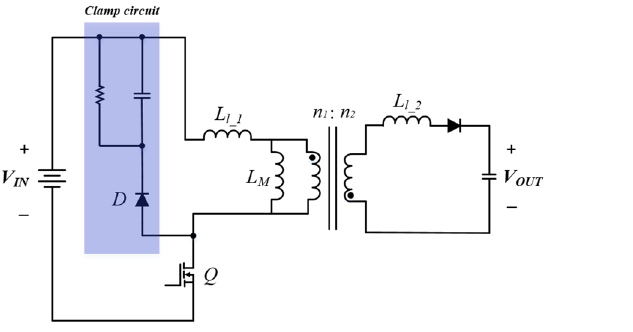
Figure 3. Two flyback converter with one switch. ( a ) one-switch flyback converter with clamp cir- cuit; ( b ) two-switch flyback converter with clamp circuit .